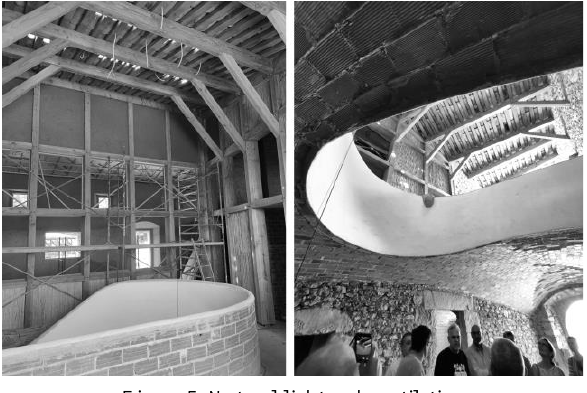
Figure 5. Natural light and ventilation provided by the central